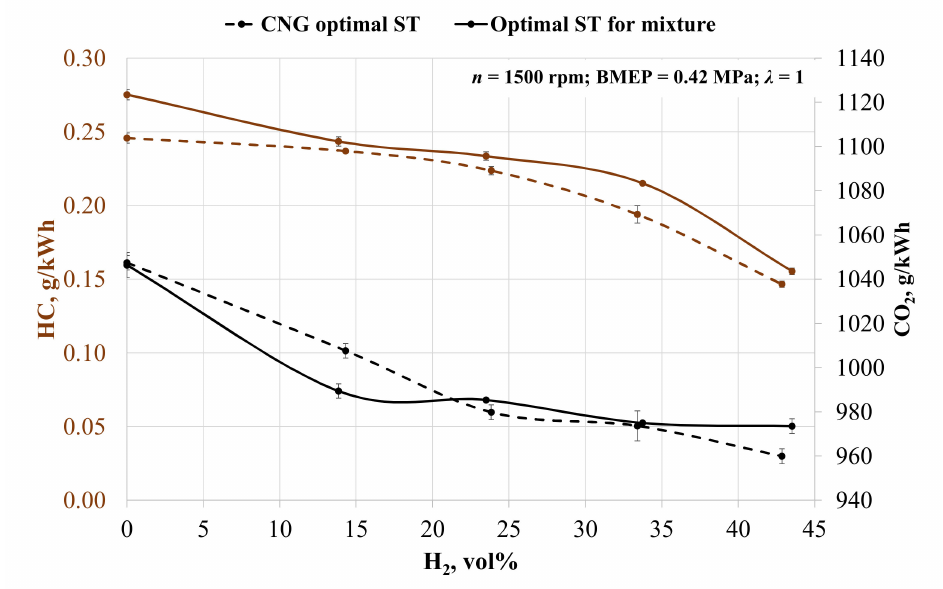
Figure 5. Change in the specific emissions of unburned hydrocarbons (HC) and carbon dioxide (CO 2 ) depending on the volumetric fraction of hydrogen and spark